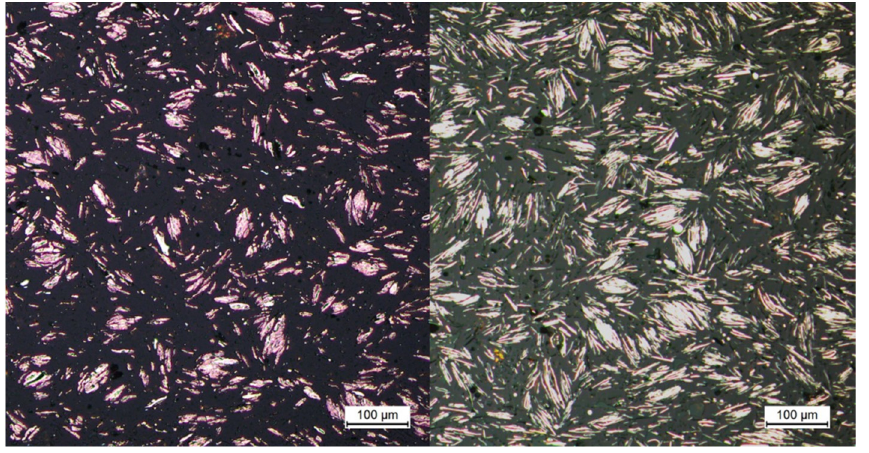
Figure 11. Cooling without external force ( left ), cooling with an external force produces by the piston of the capillary rheometer ( right ) for the same plastic.